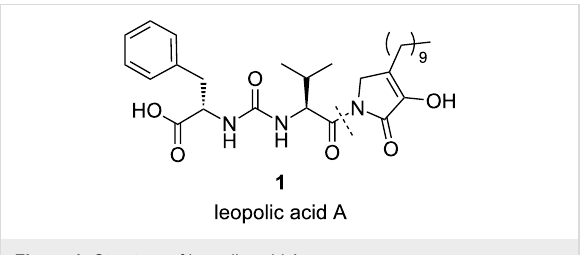
Figure 1: Structure of leopolic acid A.